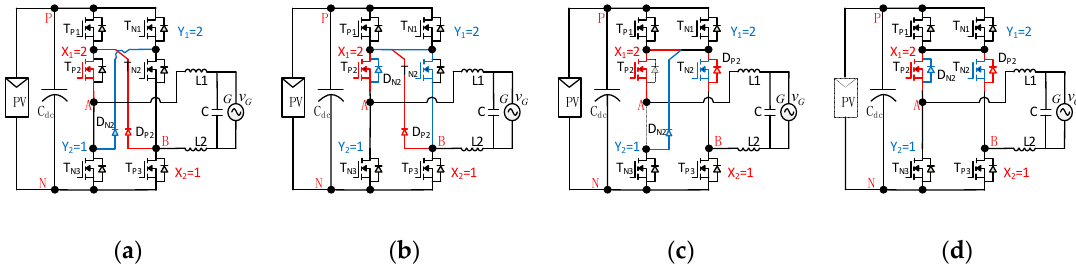
Figure 13. Four topologies derived from X 1 = 2, X 2 = 1, Y 1 = 2, and Y 2 = 1. ( a ) R6 [16,31]; ( b ) R7 (circuit one); ( c ) R7 (circuit two); ( d ) R7 (circuit three) [12]. Similarly, one topology derived from X 1 = 2, X 2 = 1, Y 1 = 1, and Y 2 = 2 is shown in Figure 14.